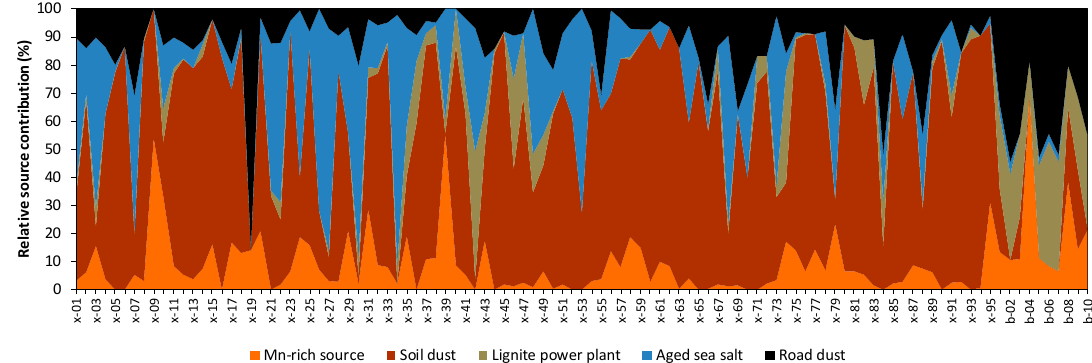
Figure 3. The relative contributions of the sources to each sample.